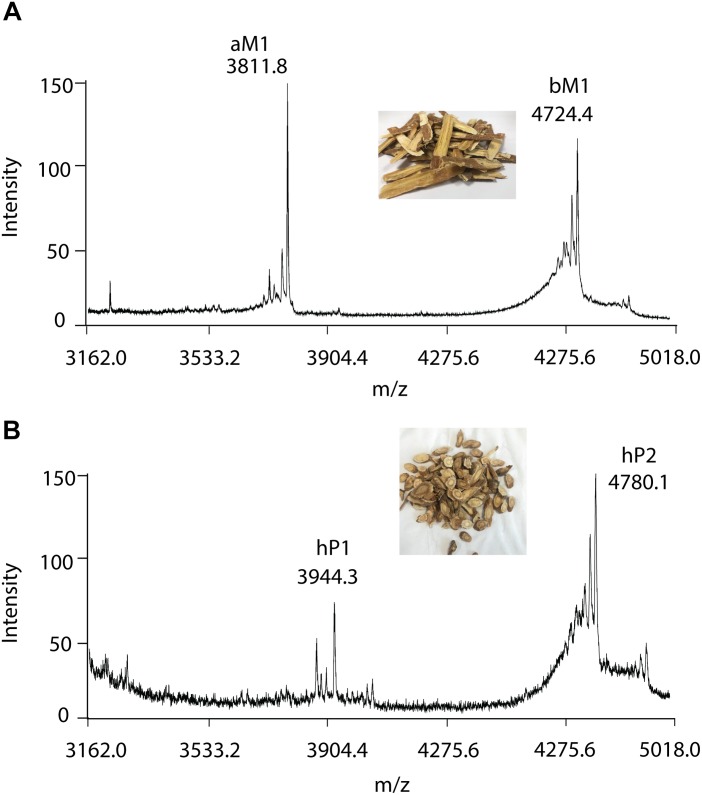
MALDI-TOF MS profile of (A) RA and (B) RH samples. Two major CRPs are designated as aM1 and bM1, with a molecular weight of 3811.8 and 4724.4 Da in RA samples, respectively. Similarly, with molecular weights of 3944.3 and 4780.1 Da, two major CRPs in RH samples were designated as hP1 and hP2, respectively.